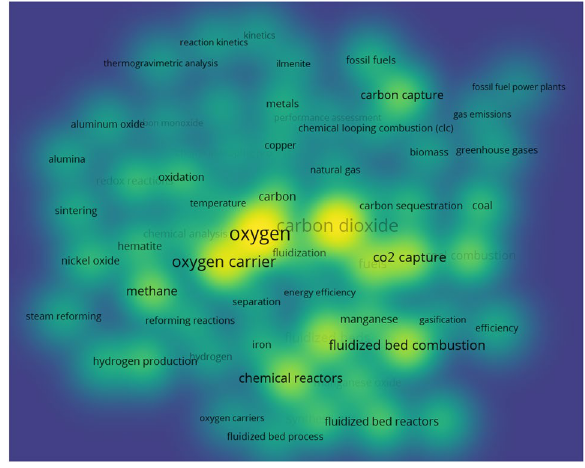
Fig. 12 Bibliometric map (oxygen transporter) (Source: www. vosvi ewer.